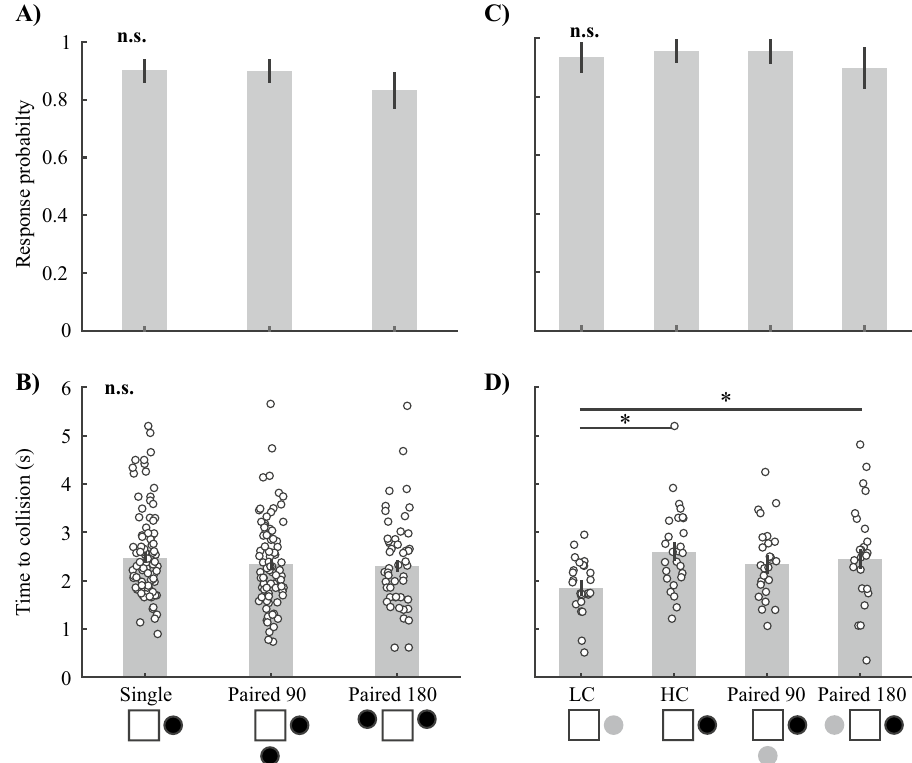
Figure 2. The probability and timing of the escape response to the approach of single and paired looming stimuli. There is no difference in ( A ) response probability and ( B ) response timing (time to collision) to single and paired stimuli of equal contrast (experiment 1). ( C ) Response probability also did not change in response to single or paired stimuli that varied in contrast (experiment 2). ( D ) A single low contrast (LC) stimulus elicited a later response than stimuli that contained a high contrast (HC) stimulus (regardless of whether they were paired with a LC stimulus or not). Diagrams below the x-axis show the number, contrast, and angular separation of looming stimuli. The square in the centre of each diagram represents the four computer monitors. Solid black circles represent looming stimuli of − 100% contrast and solid grey circles represent looming stimuli of − 40% contrast. All bars represent estimated marginal means (± SE) and white circles in ( B ) and ( D ) show each observation. The solid black lines and asterisk symbols (*) connect levels of treatments that were found to be significantly different (* 0.01 ≤ p < 0.05, n.s. = not significant). All statistical tests on response timing were performed on transformed data but were back transformed for display (see methods for